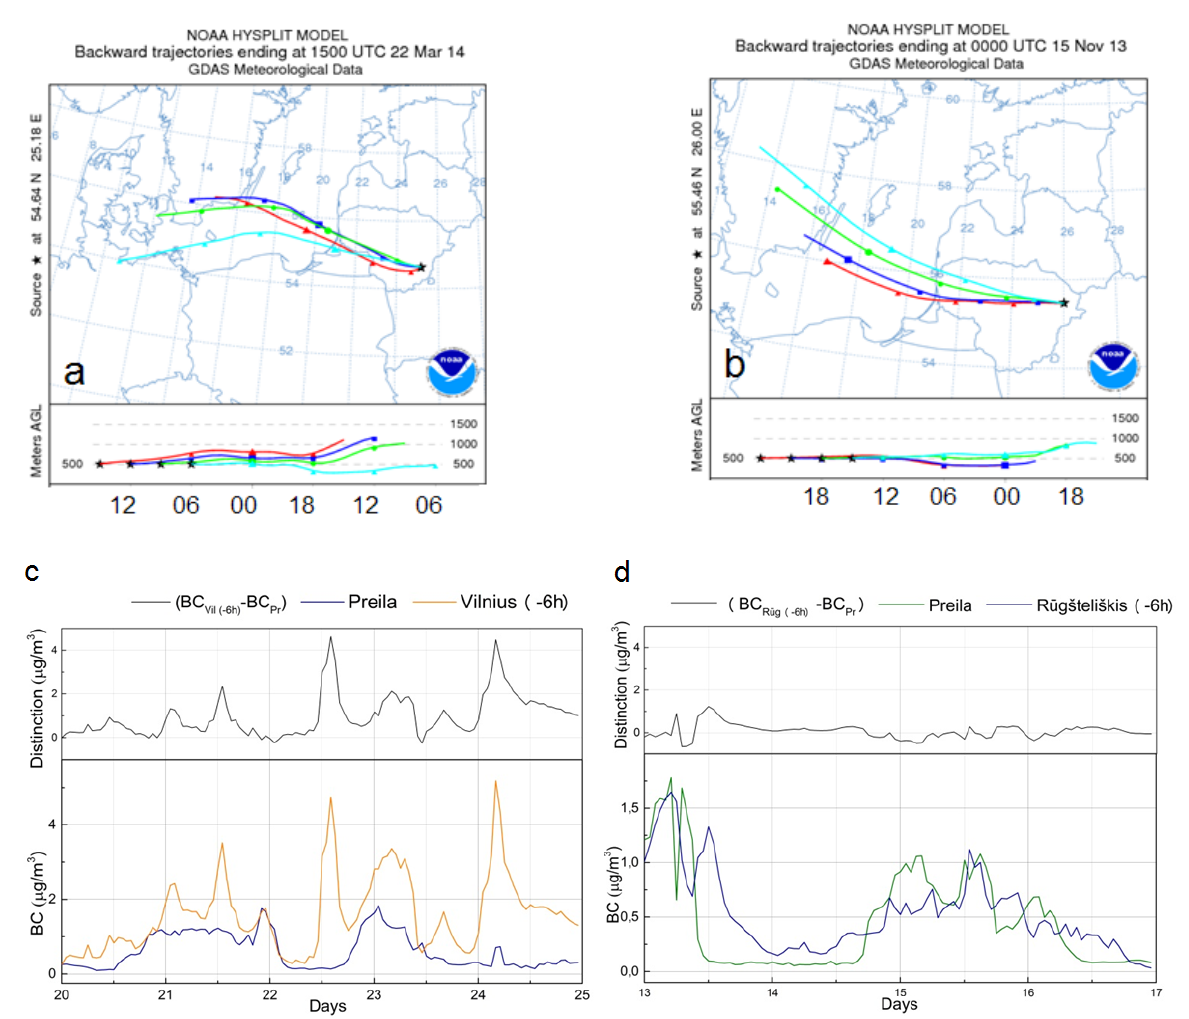
Figure 3. Air mass backward trajectories on ( a ) 22 March 2014 and ( b ) 15 November